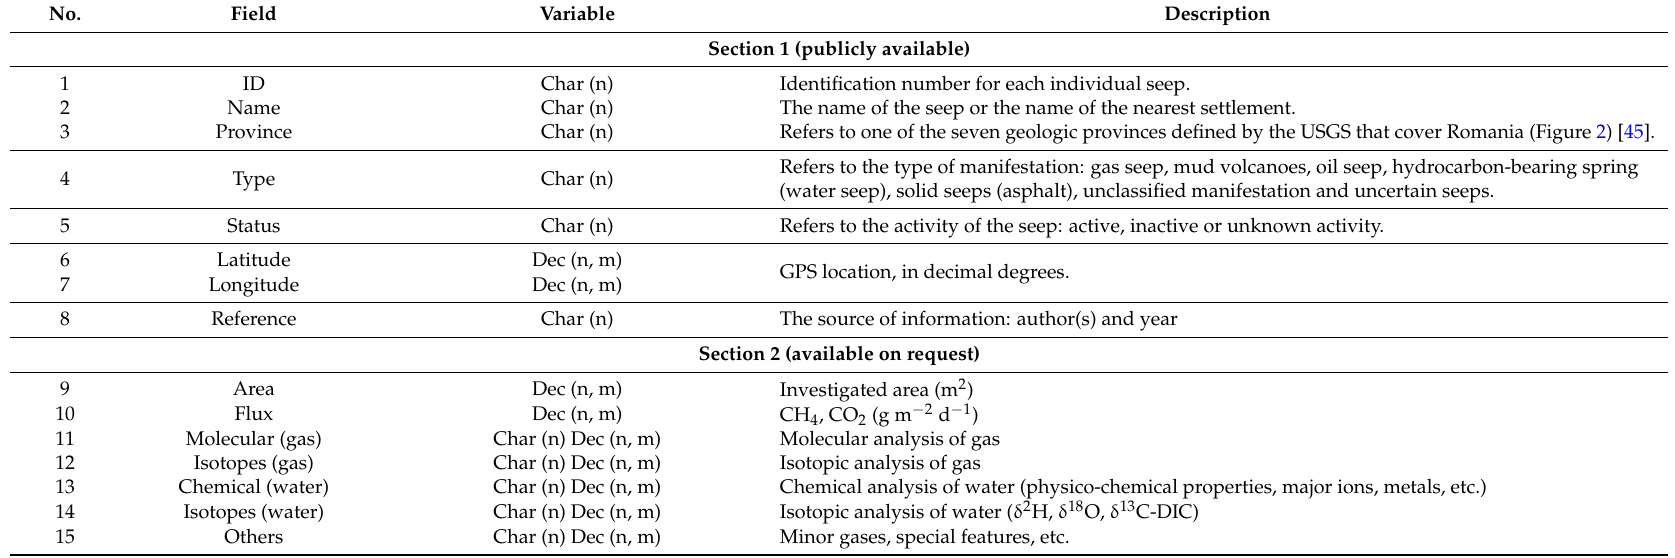
Table 1. Structure of the HYSED-RO